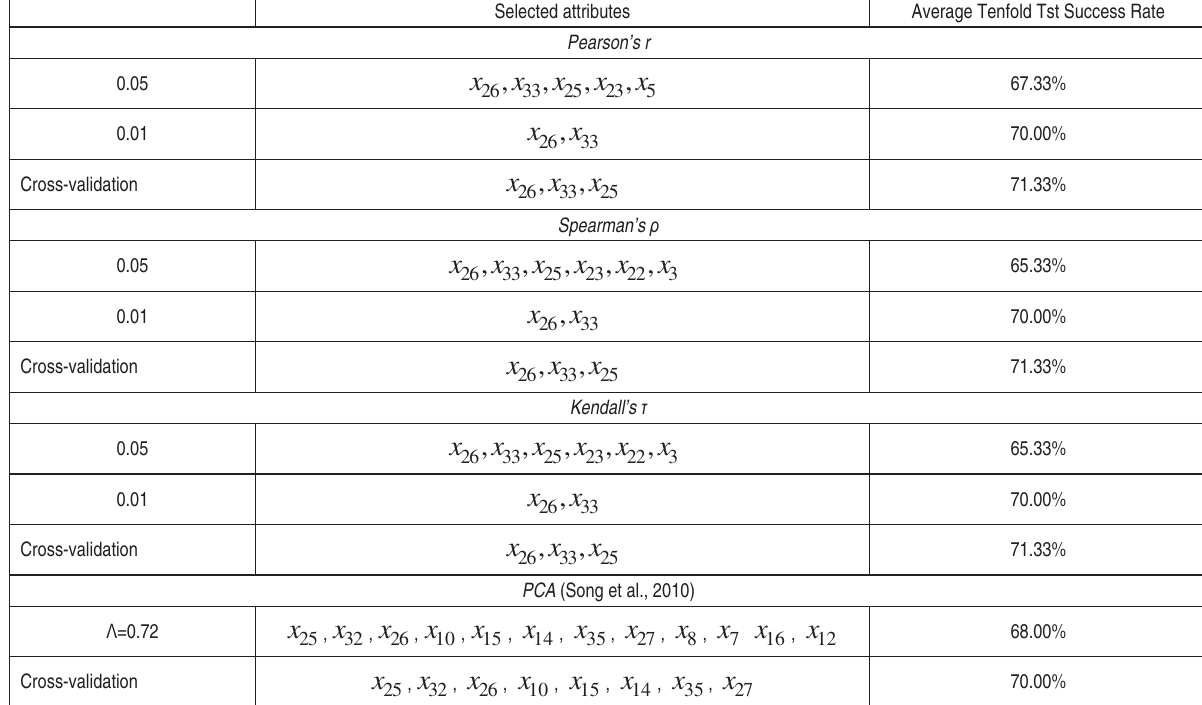
Table 3. The selected attributes presented in descending order according to their |r| value Selected